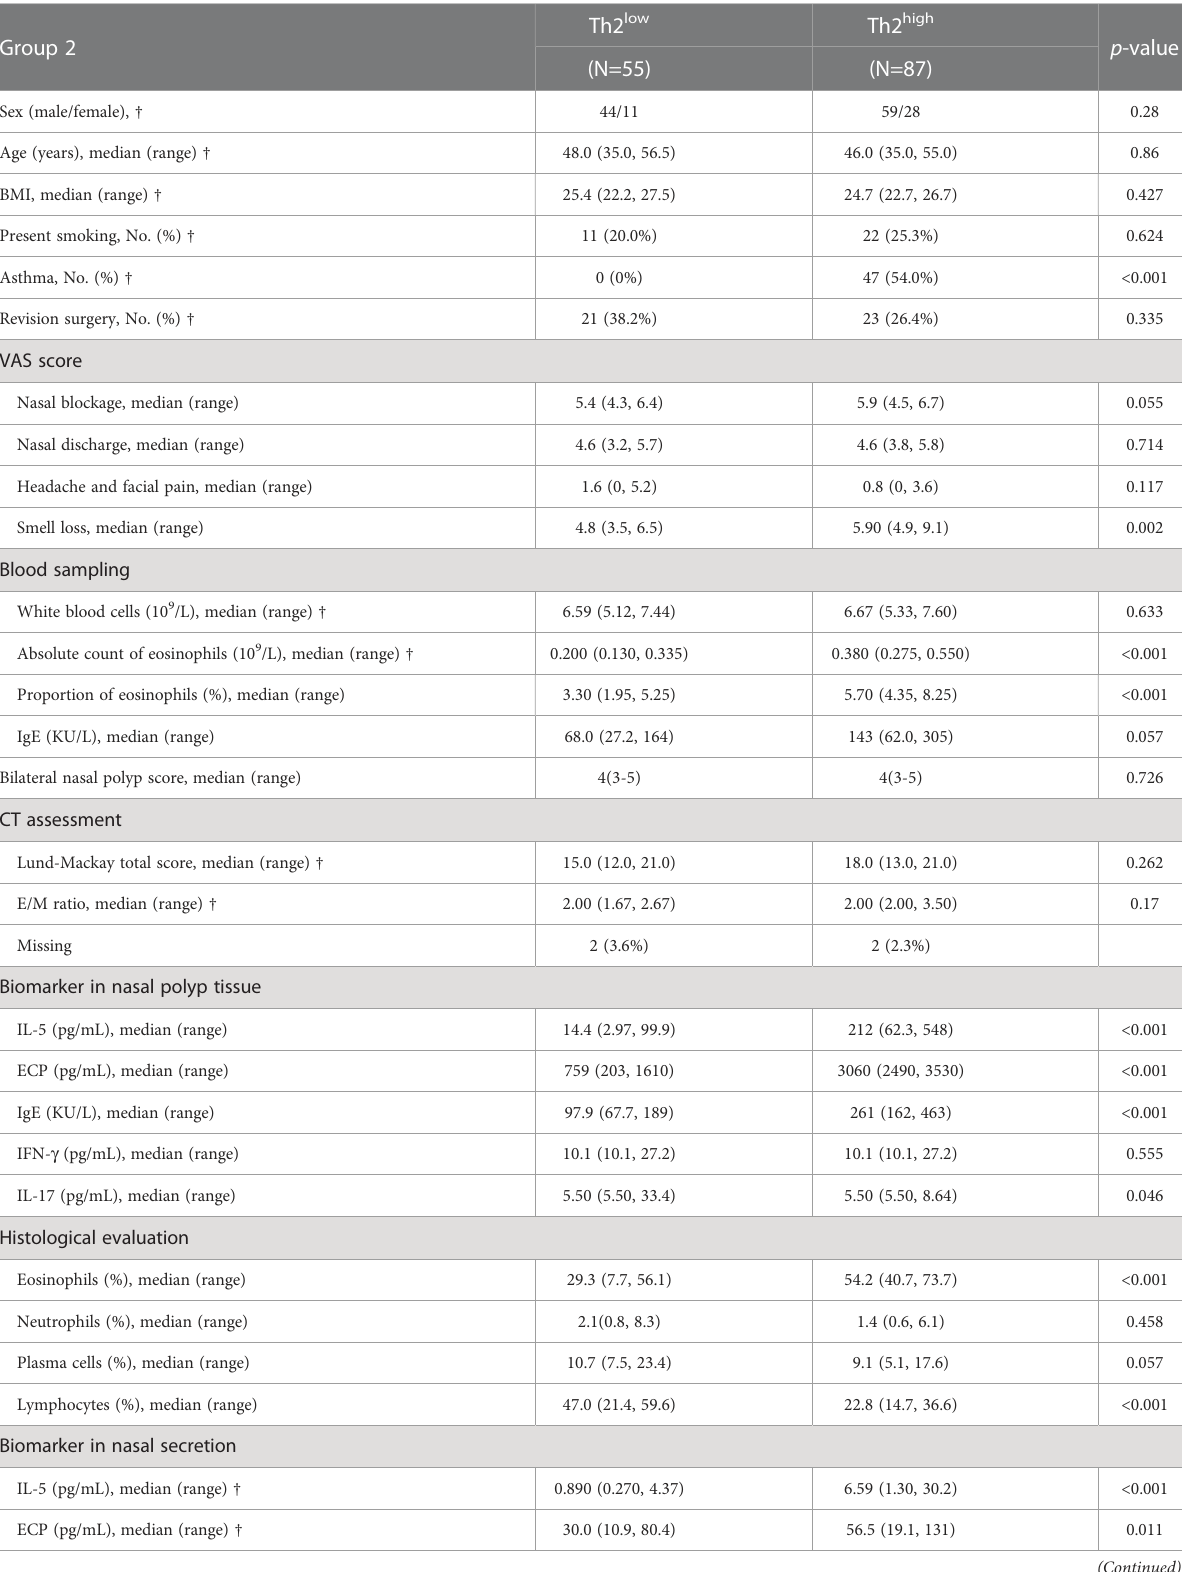
TABLE 2 Demographic and clinical characteristics of CRSwNP patients investigated for development of the predicting